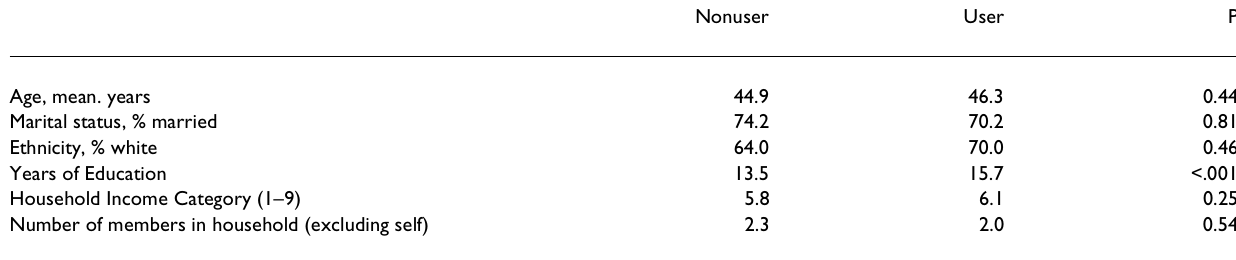
Table 1: Characteristics of Participants: Users and Nonusers of CAM (N = 115)